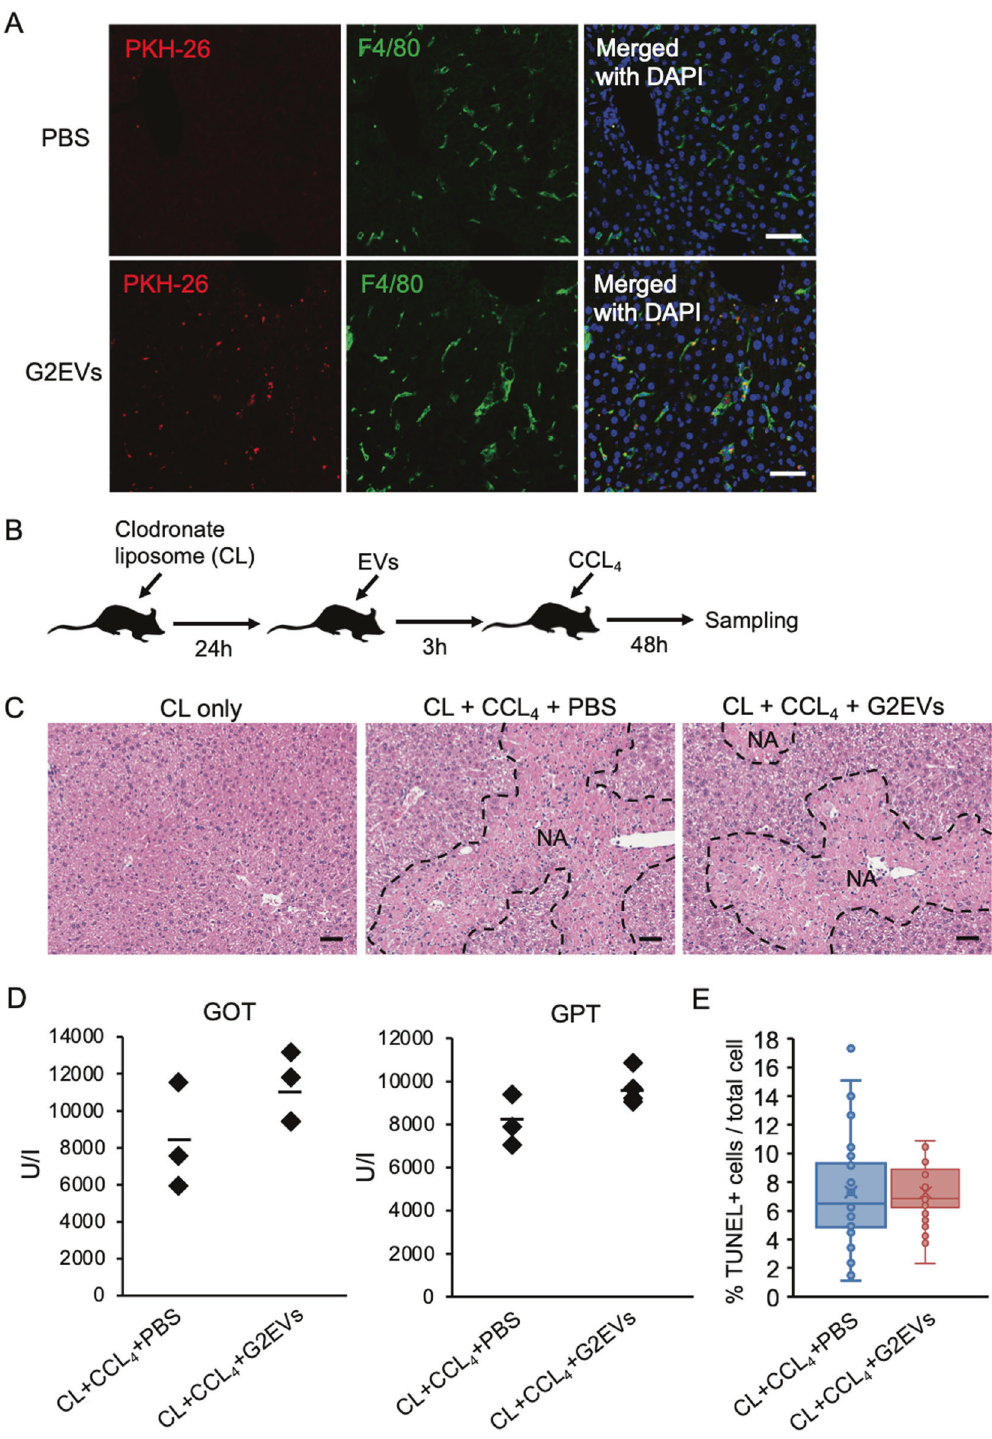
Fig. 3 Liver resident macrophages are responsible for protective effects of hepatocyte-derived EVs. A F4/80 (green) and DAPI (blue) staining of liver sections of the mice treated with PBS or PKH-26 labeled HepG2-EVs (red). B Timeline for the experiment of CL and EV treatments for CCL 4 -induced acute liver injury in mouse model. C HE staining of liver sections of the mice treated with CL + CCL 4 + PBS or CL + HepG2-EVs. D The Serum GOT and GTP were measured for the mice treated with CL + CCL + CCL 4 E TUNEL staining of liver sections of the mice treated with CL + CCL 4 + PBS or CL + CCL 4 + HepG2-EVs. TUNEL positive cells were enumerated in 10 fi elds from 3 mice. Ratio to total cells was calculated. Statistical analysis was performed using student ’ s t test. Black and white bars indicate 50 μ m. CL clodronate liposome.